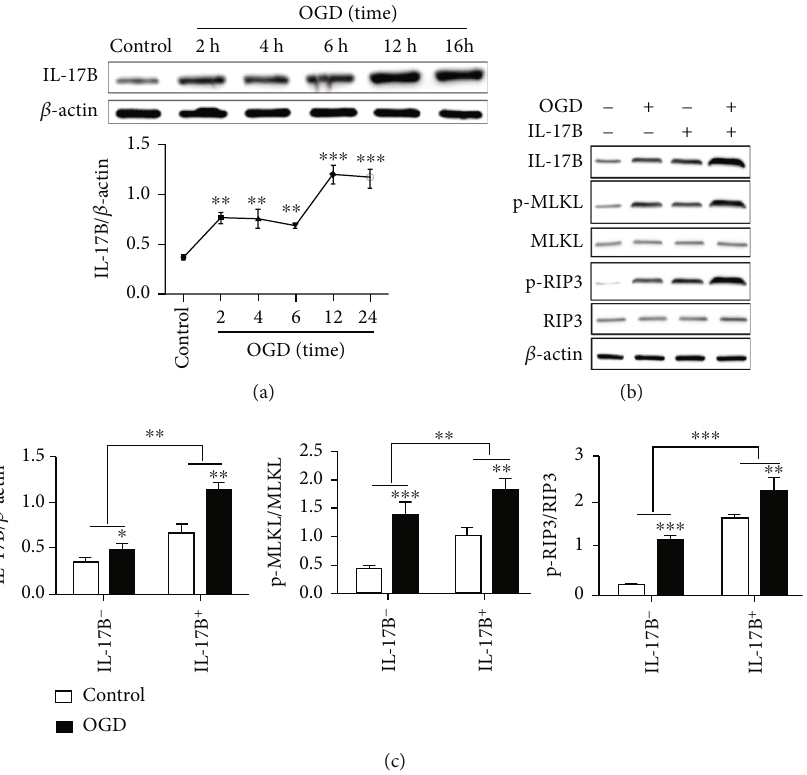
Figure 2: IL-17B is highly expressed in OGD cells and promotes the activation of the RIP3/MLKL pathway. (a) Western blot for the detection of IL-17B protein in the OGD cells using β -actin as the internal reference. The line chart showed the expression trend of IL-17B protein at di ff erent OGD time. (b) Western blot for the detection of RIP3, p-RIP3, MLKL, and p-MLKL proteins in each cell group, using β -actin as the internal reference. The ImageJ image software analysis was used to test and analyze the expression ratios. (c) The bar chart shows the ratio of protein gray value to total protein gray value. ANOVA was used for statistical analysis. ∗ P < 0 : 05 , ∗∗ P < 0 : 01 , and ∗∗∗ P < 0 : 001